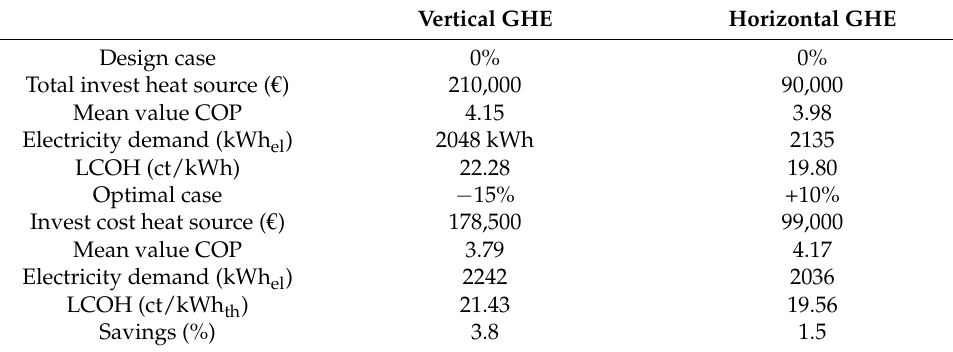
Table 8. Main indicators for the LCOH